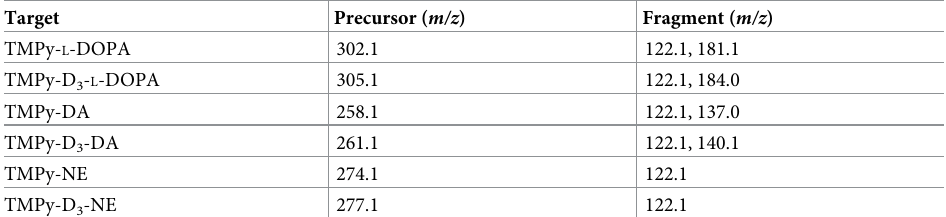
Table 2. Selected monitor ions and detection limit for TMPy-labelled catechol amines on